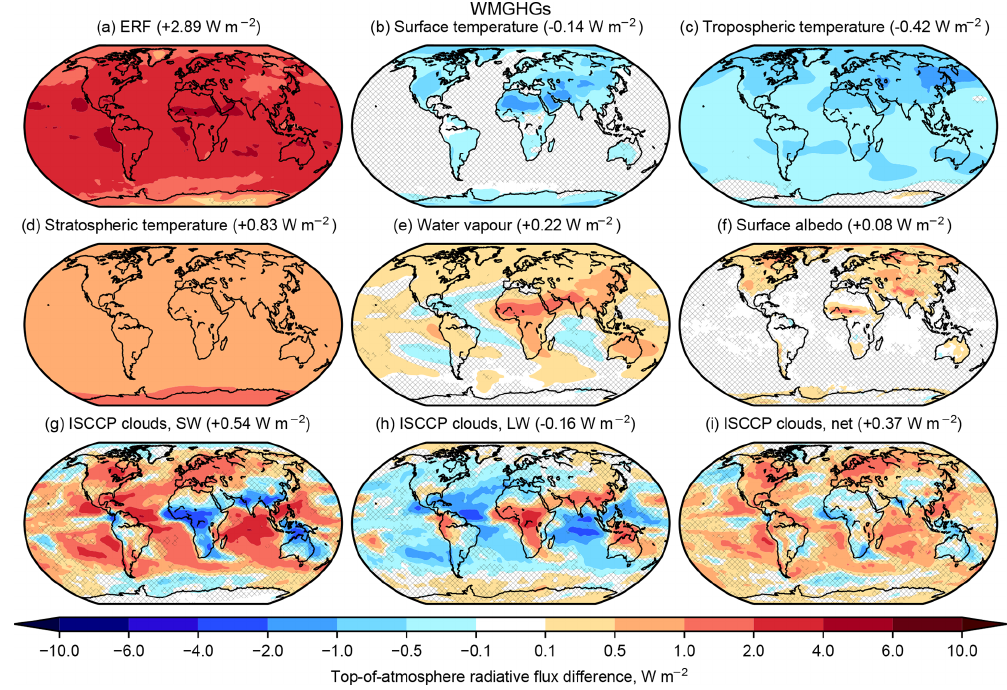
Figure 7. As Fig. 6 but for present-day WMGHG forcing.